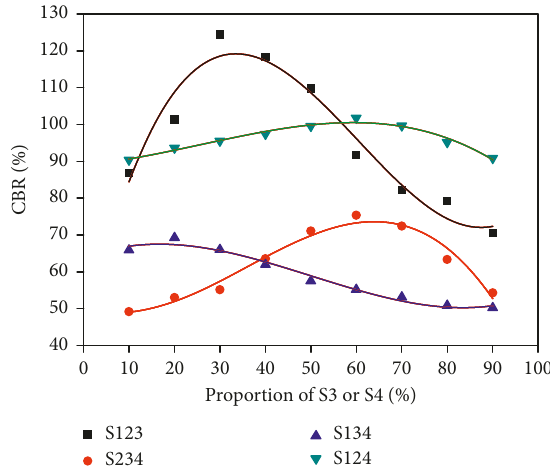
Figure 13: Influences on the CBR of different secondary aggregates mixtures.